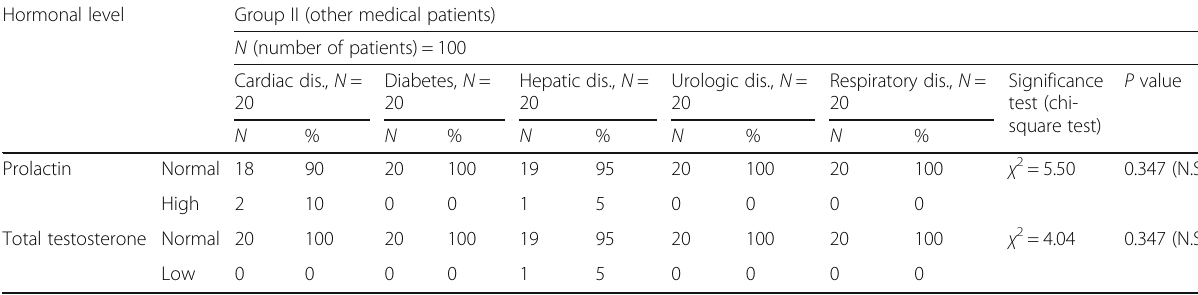
Table 10 Hormonal levels among patients of group II (other medical patients) Hormonal level Group II (other medical